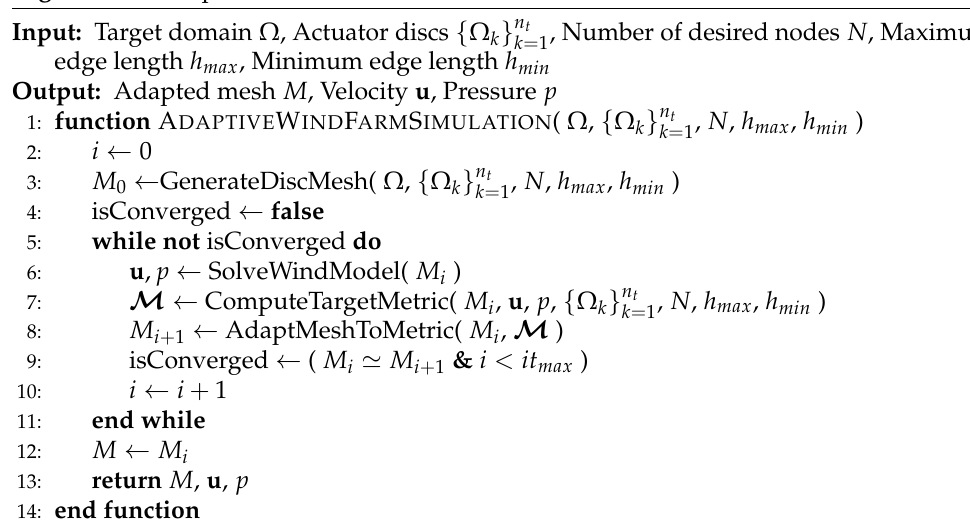
Algorithm 2 Adaptive simulation of a wind